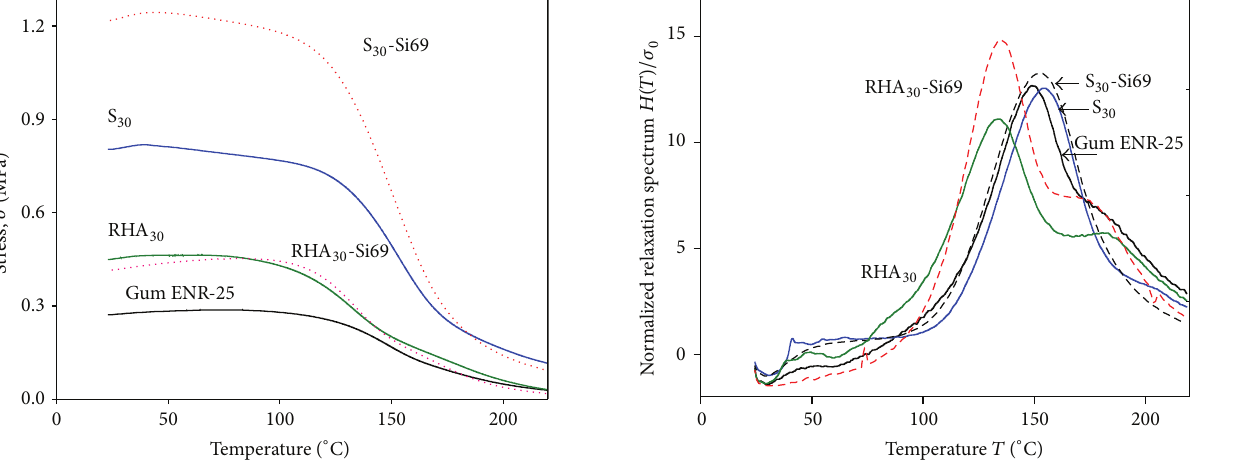
Figure 12: Stress as a function of temperature of gum and filled ENR-25vulcanizateswith30 phrofRHAandsilicawithandwithout silane coupling agent (Si69).